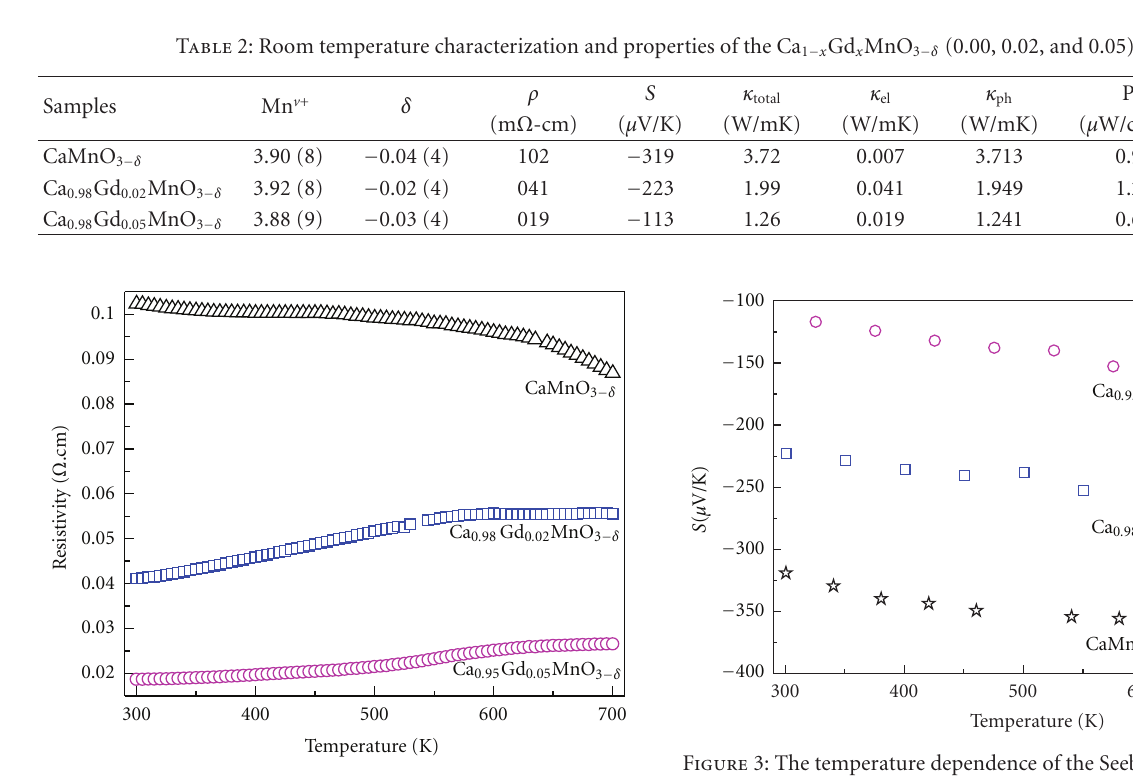
Figure 2: The temperature dependence of the electrical resistivity of the Ca 1 − x Gd x MnO 3 − δ (0.00, 0.02, and 0.05).